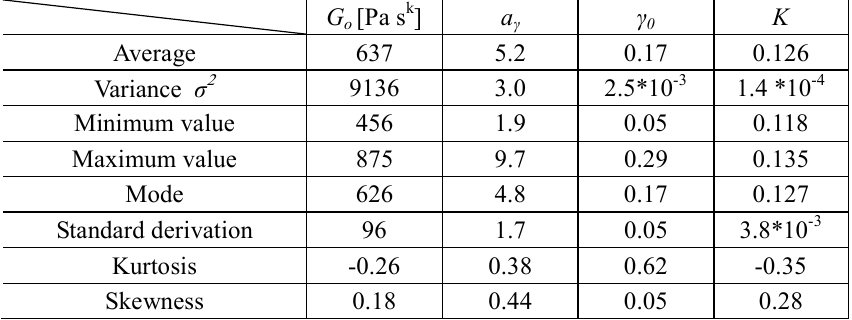
Table 2 Value of each